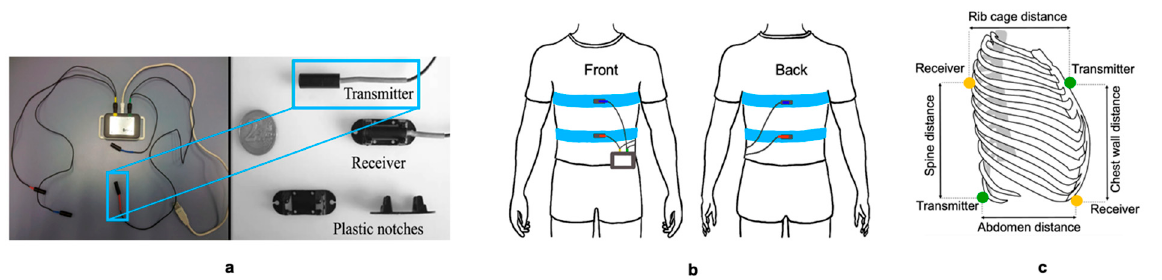
Figure 4. ( a ): Overview of the RMP system; ( b ): position of transmitters and receivers on the subject using elastic belts; ( c ): distances measured using the RMP system.